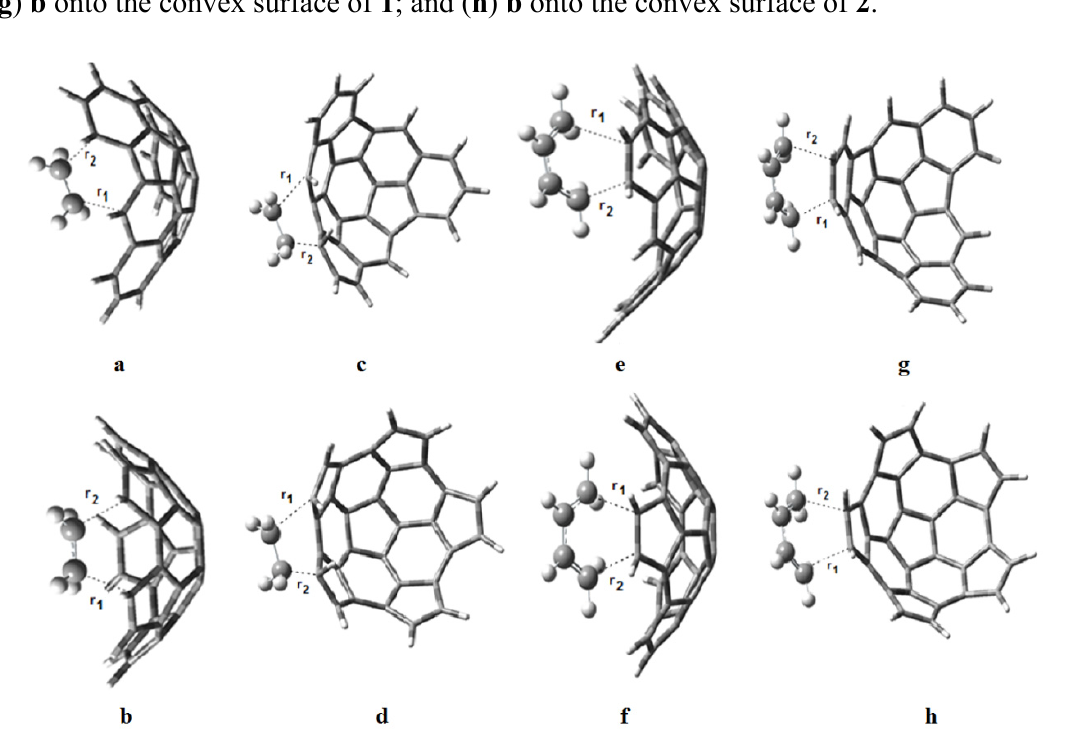
Figure 5. Transition state structures for the reactions of ( a ) e onto the concave surface of 1 ; ( b ) e onto the concave surface of 2 ; ( c ) e onto the convex surface of 1 ; ( d ) e onto the convex surface of 2 ; ( e ) b onto the concave surface of 1 ; ( f ) b onto the concave surface of 2 ; ( g ) b onto the convex surface of 1 ; and ( h ) b onto the convex surface of 2